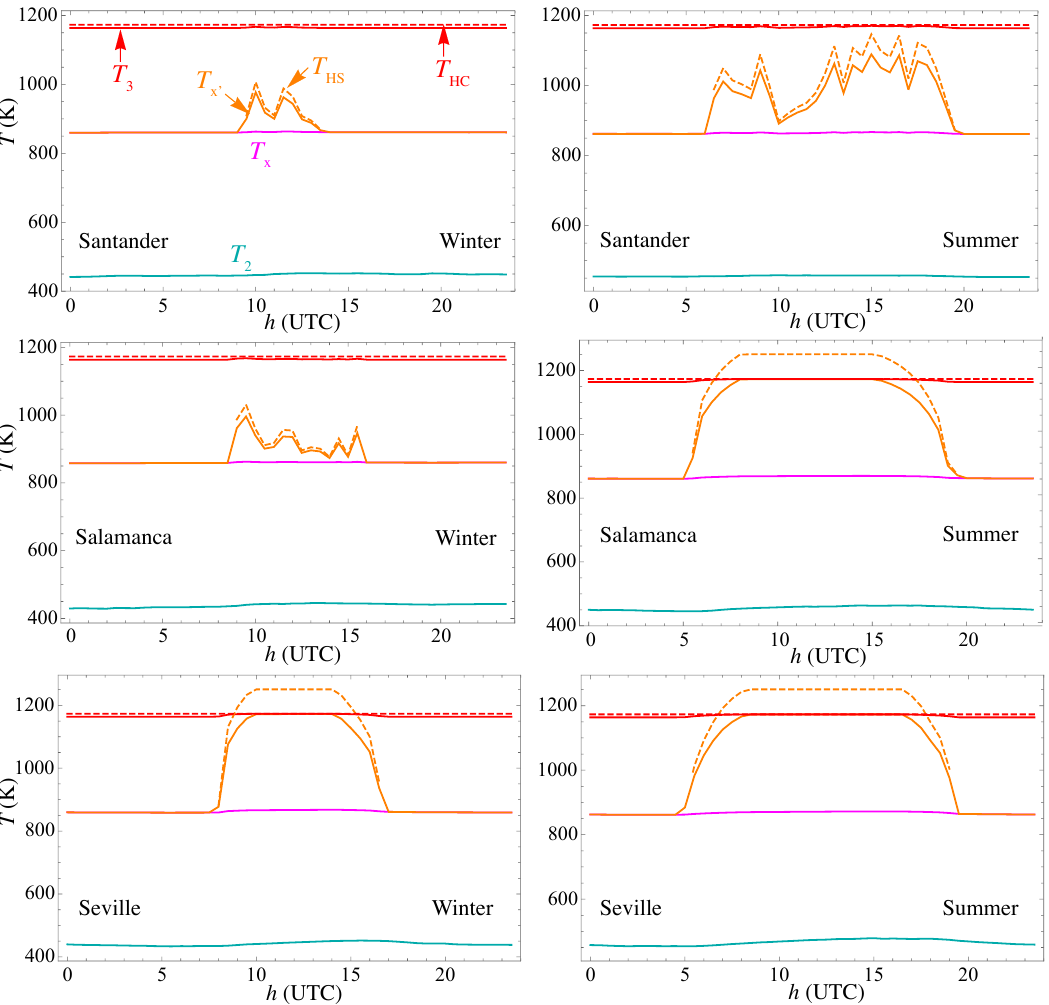
Figure 6. Daily evolution of the working fluid temperatures for the same places and particular days as Figure 5. The notation for temperatures corresponds to the thermodynamic states in Figure